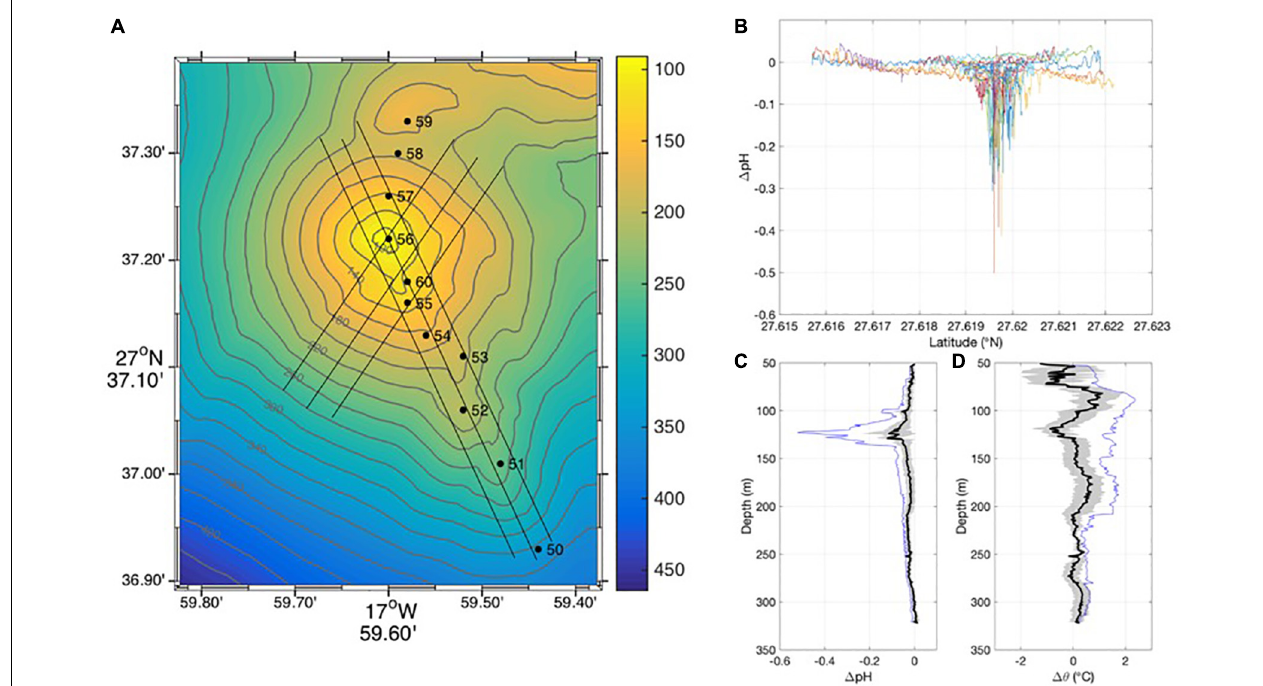
FIGURE 3 | Physical–chemical anomalies over Tagoro submarine volcano. (A) High resolution bathymetry of Tagoro submarine volcano. CTD stations are marked with dots from 50 to 60. Blank lines represent the CTD tow-yo transects over the main volcanic edifice. (B) pH anomaly for every tow-yo transect with latitude. (C) Vertical mean pH anomaly (bold line) with its standard deviation (gray) and the minimum values (blue line). (D) Vertical mean potential temperature anomaly (bold line) with its standard deviation (gray) and the maximum values (blue